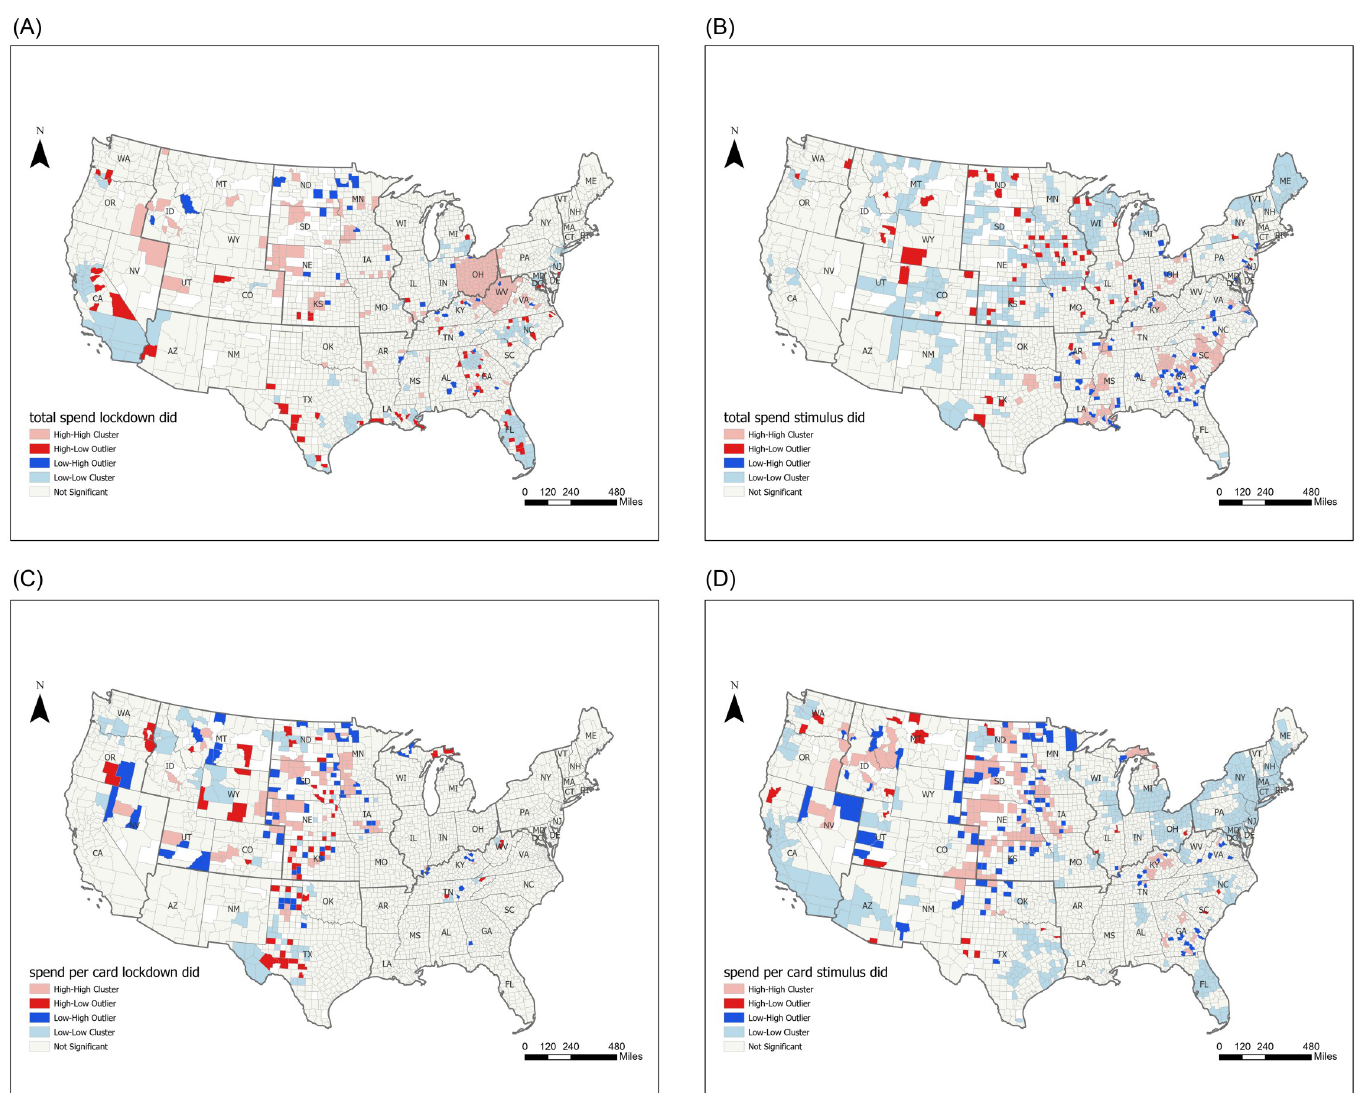
Fig 3. Local Moran’s I spatial association analysis of the spending DID metric, which involves two differences: The first is to subtract the daily average county (or per card) spending in 2020 by the same-day spending in 2019; and the second is to subtract this year-over-year dollar change after each treatment by that before each treatment (the lockdowns or stimulus payments, respectively). (a) Local Moran’s I spatial statistic for county spending DID metric (After Lockdown). (b) Local Moran’s I spatial statistic for county spending DID metric (After Stimulus). (c) Local Moran’s I spatial statistic for per card spending DID metric (After Lockdown). (d) Local Moran’s I spatial statistic for per card spending DID metric (After